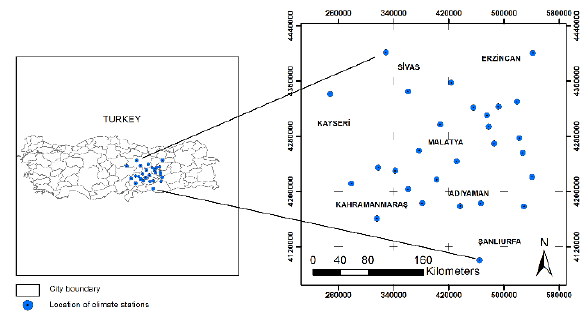
Figure 1. Location of study area and climate stations in the study area.